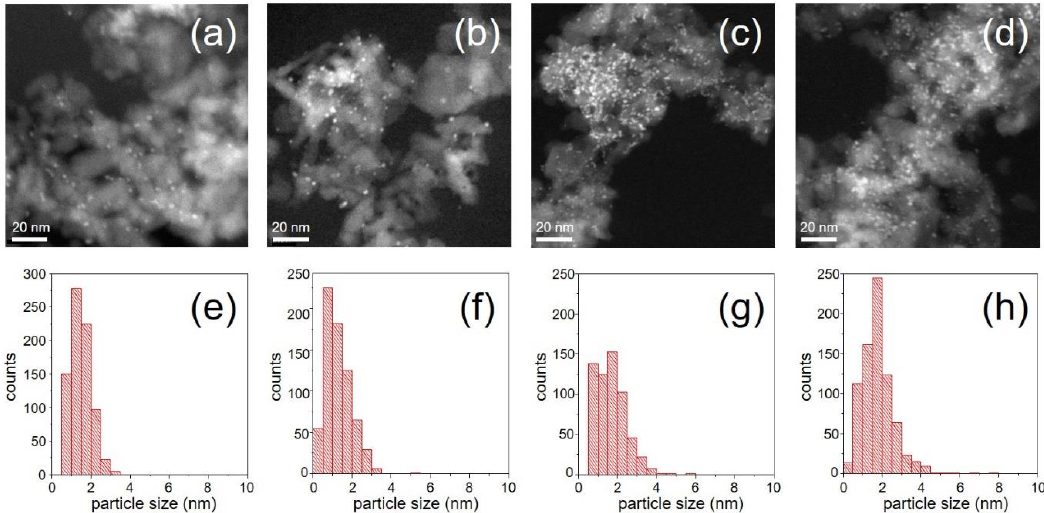
Figure 1. ( a – d ) HAADF-STEM images of 1 wt.%, 2 wt.%, 3.5 wt.% and 5 wt.% Pd/Al 2 O 3 , respectively. ( e – h ) Corresponding particle size distributions.